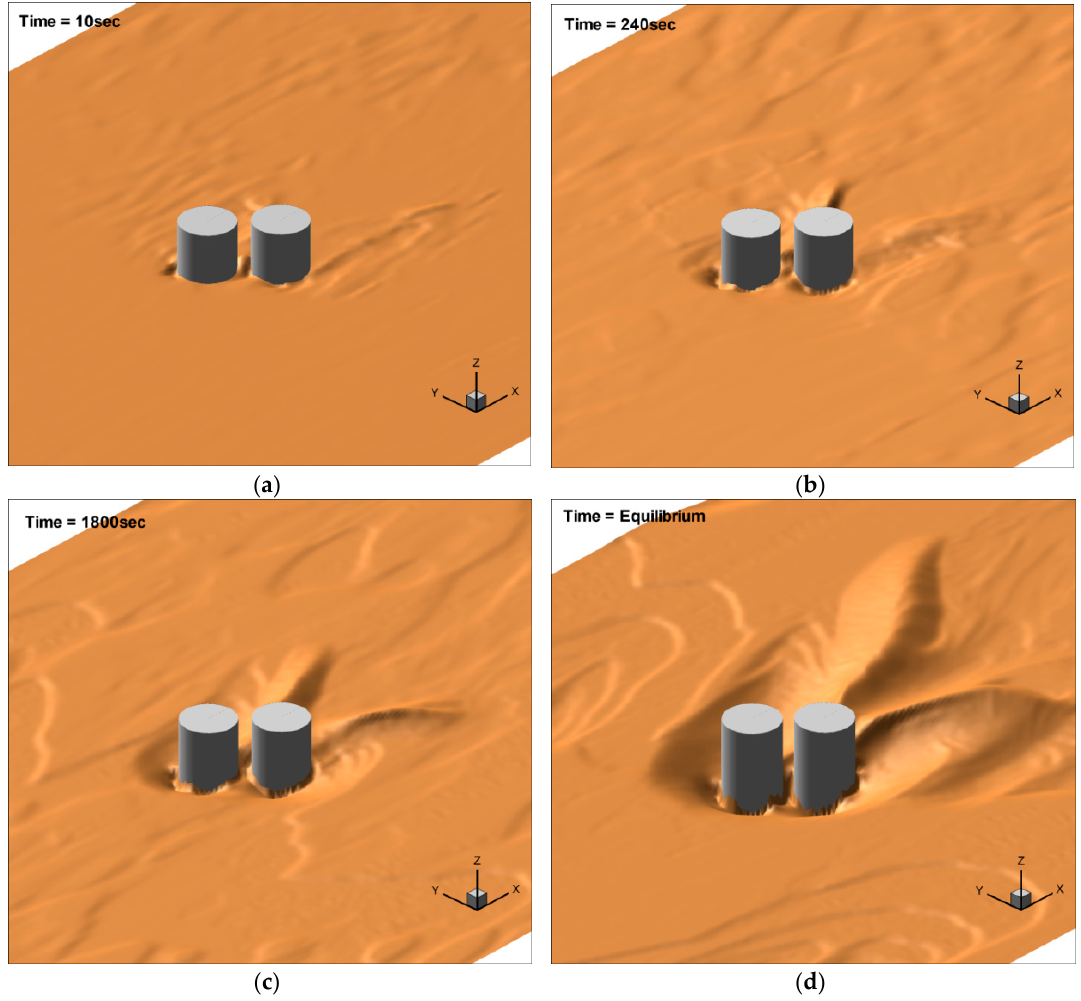
Figure 6. Instantaneous views of the bed elevation for an alignment angle of 45° with s / D = 1.25 at 10 s, 240 s, 1800 s and equilibrium: ( a ) Time = 10 s; ( b ) Time = 240 s; ( c ) Time = 1800 s; ( d ) Time = Equilibrium.